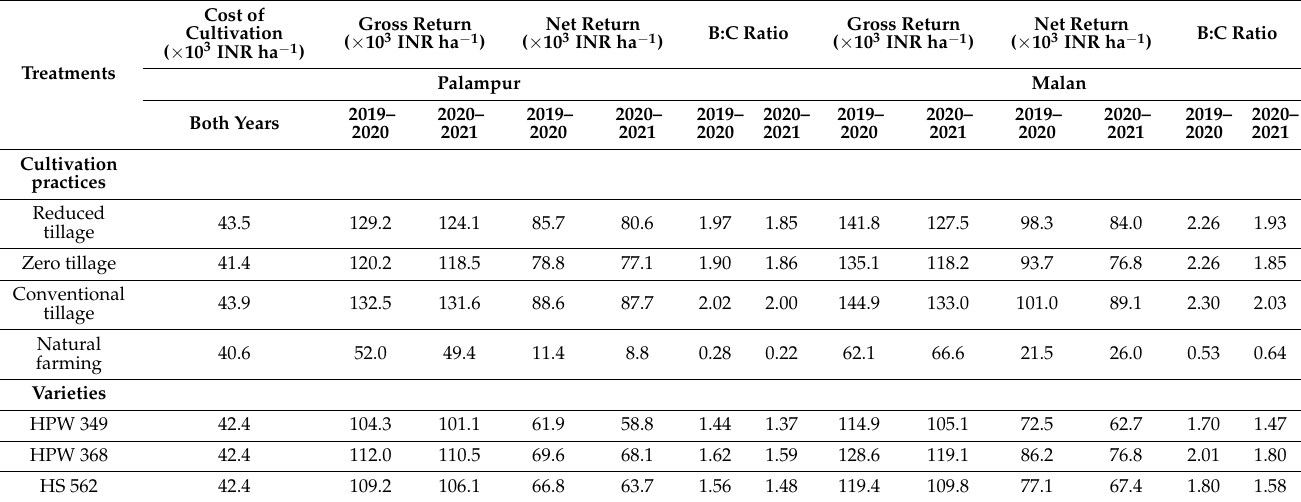
Table 3. Effect of cultivation practices on the profitability of different wheat varieties at Palampur and